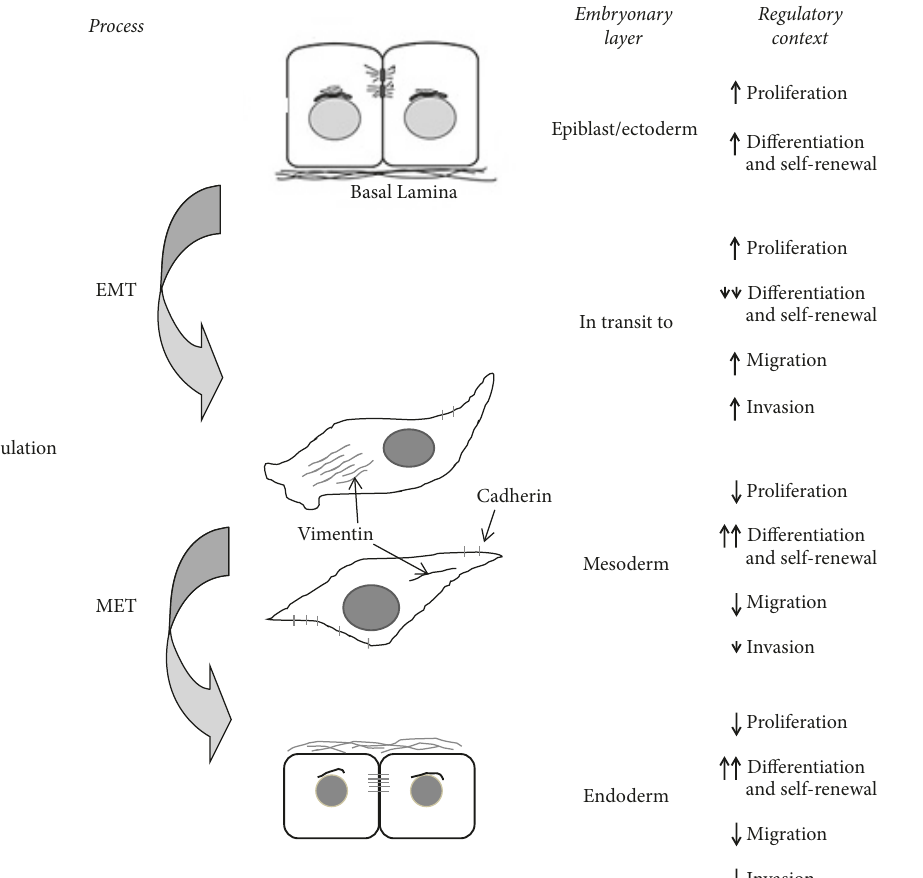
Figure 2: Differences established during gastrulation through the EMT and MET processes. The EMT and MET processes involve a specific transcriptional regulation and they are responsible for simultaneously orchestrating processes of proliferation, migration, cell differentiation, and invasion. However, these programs are different depending on the embryonic layer of origin. The arrowhead or arrow indicates the “intensity” of the